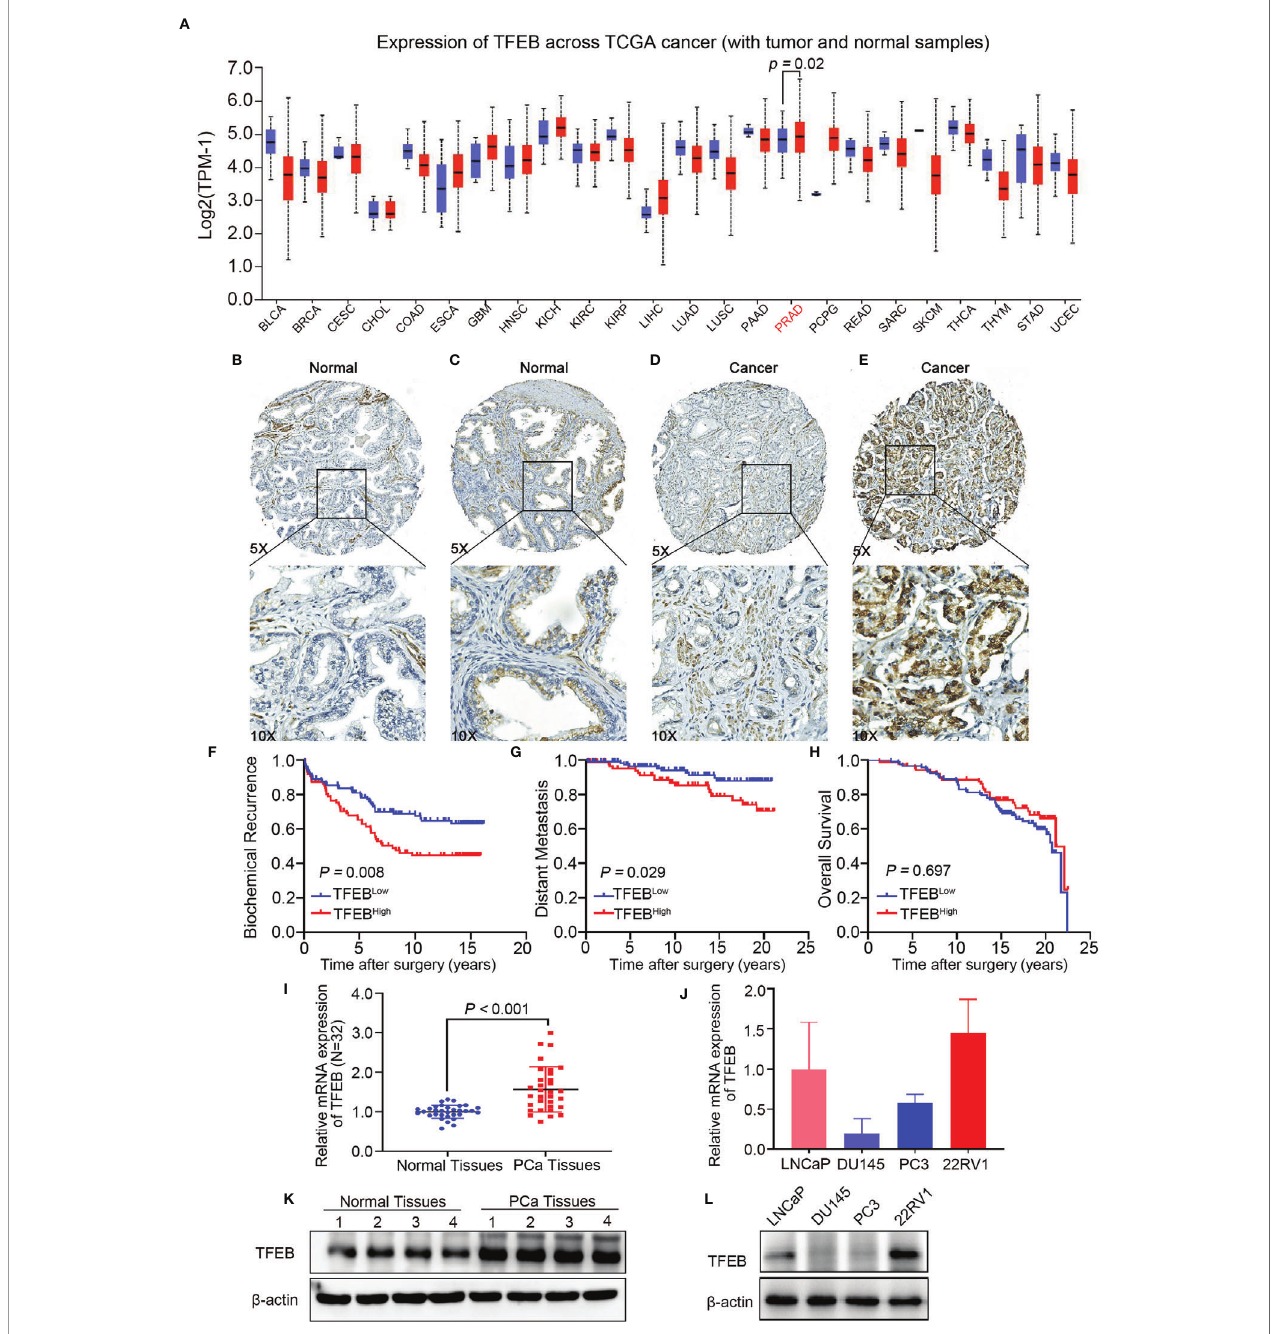
FIGURE 1 | TFEB expression in prostate tissues microarray and its association with PCa progression. TFEB is often upregulated in PCa and is associated with poor outcome in PCa patients. (A) Bioinformatics analysis of TFEB in Pan-cancer of TCGA database. And TFEB mRNA expression was increased in PCa compared to normal tissues ( p =0.02). (B – D) IHC analysis of TFEB expression in 225 PCa samples. (B) TFEB staining is negative in benign prostate tissue. (C) Moderate TFEB staining in benign prostate tissue. (D) The weak staining of TFEB in PCa tissues. (E) Strong cytoplasmic and perinuclear TFEB staining can be detected in PCa tissues. (F – H) Kaplan-Meier curves representing different endpoint survival of 205 patients treated with radical prostatectomy for prostate cancer strati fi ed by TFEB status. (F) Biochemical recurrence-free survival ( p =0.008). (G) Metastasis-free survival ( p =0.029). (H) Overall death-free survival ( p =0.697). (I) qRT-PCR results showed that the mRNA expression of TFEB was increased in our cohort. (J) Quantitative protein expression of western-blot showed TFEB expression was increased in PCa tissues compared to adjacent tissues. (K, L) The mRNA and protein expression of TFEB was decreased in DU145 and PC3 compared to 22RV1 and LNCaP cell